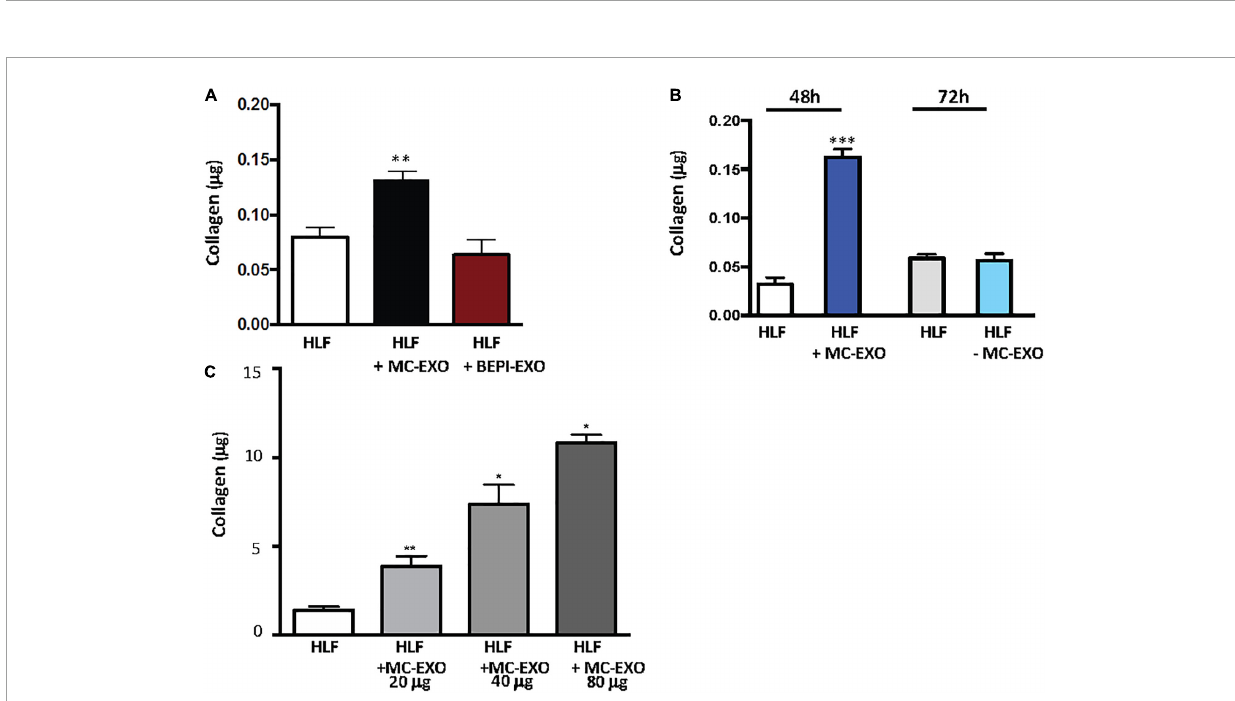
FIGURE2 Stimulation of collagen production by MC-EXO uptake in HLFs. (A) Secreted collagen was measured in the supernatants of HLF, HLF + MC-EXO (40 µ g total protein), HLF + TGF- β (10 ng/ml), and HLF + bronchial epithelial cell exosomes (BEPI)-EXO (40 µ g total protein) after 72 h. All assays performed in triplicate and normalized to total protein ( µ g). ∗∗ P < 0.01 versus HLF, n = 5 samples/group. (B) Secreted collagen measured in the supernatants of HLF and HLF + MC-EXO (40 µ g total protein) at the 48 h time point and then at the 72 h time point where the MC-EXO have been removed from the supernatant after 48 h. All assays performed in triplicate and normalized to total protein and normalized to total protein ( µ g). ∗∗∗ P < 0.001 versus HLF, n = 3 samples/group. (C) Secreted collagen measured in the supernatants of HLF and HLF with varying doses of MC-EXO. All assays performed in triplicate and normalized to total volume (700 µ l). ∗ P < 0.05, ∗∗ P < 0.01. n = 3